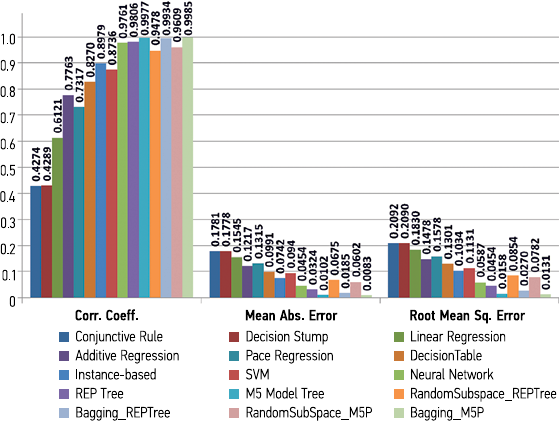
Fig. 6. Summary of base layer moduli ( K b ) prediction Fig. 4. Summary of asphalt layer moduli ( E ac ) prediction performance with data mining techniques (without including performance with data mining techniques using theoretic E ac and E ri as additional inputs) using theoretic deflection deflection basins